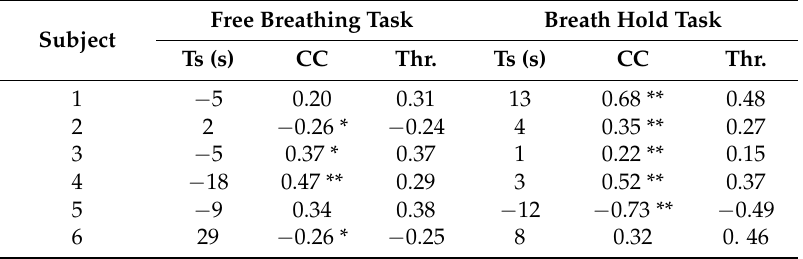
Table 4. Correlation analysis results at single subject level between GFP estimated in delta band and P ET CO 2 . The time shfit with maximum correlation coefficient (Ts), the corresponding correlation coefficient (CC), and the critical values corresponding to α = 0.05